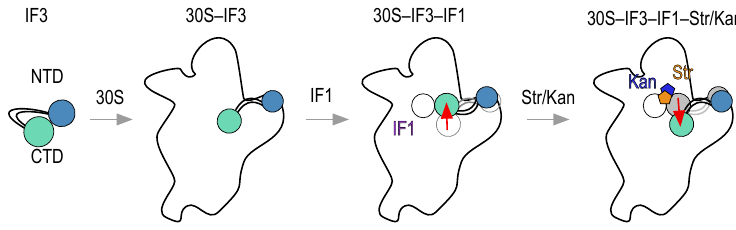
Figure 5. Scheme of IF3 movements during early stages of translation initiation and response to antibiotics streptomycin and kanamycin. IF3 binding to the 30S subunit results in opening of the factor and adopting an overall elongated state. The interaction of IF1 (purple) results in repositioning of IF3, probably shifting the CTD (magenta) towards the P-site and possibly interacting with IF1. Streptomycin (orange) and kanamycin (blue) would perturb the equilibrium between binding sites of IF3, promoting a displacement of the factor. Red arrows indicate possible movements of IF3. Gray shadows indicate IF3 states prior to the interaction of the binder with the 30S subunit.